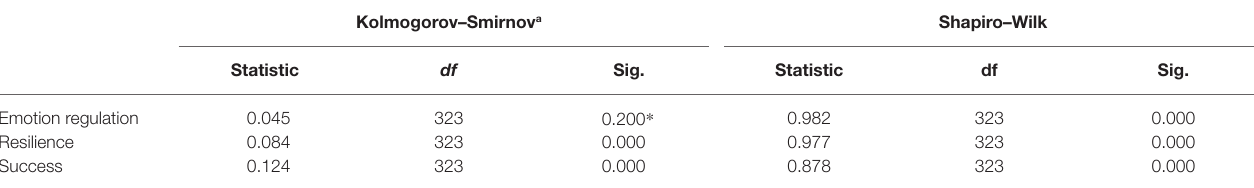
TABLE 3 | Normality test.